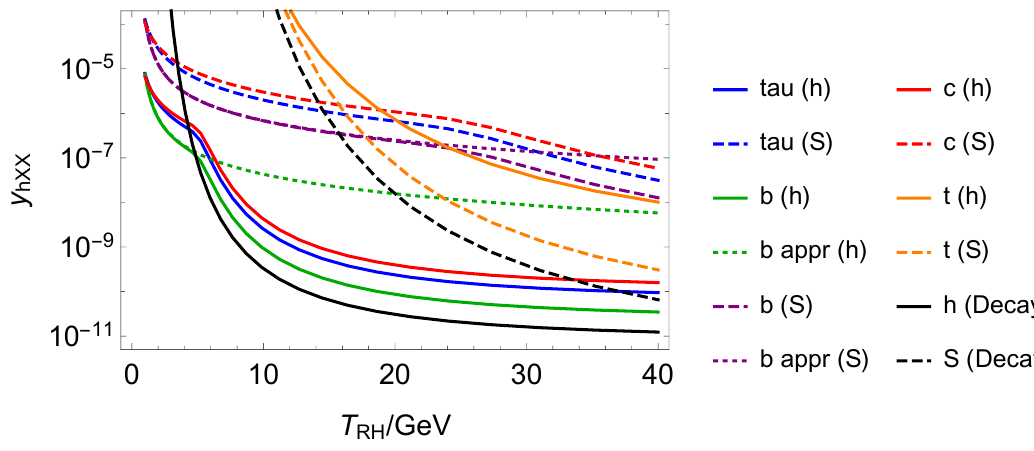
Figure 2 . Relative contributions of various annihilation channels, f ¯ f → X ¯ X , as a function of the reheat temperature for m X = 1 GeV, m S = 500 GeV, sin θ h = 0 . 1 . For each channel, we plot the effective Yukawa coupling, y hXX , needed to obtain the measured relic abundance. Lower curves correspond to the more dominant channels. The dotted curves are obtained using the approximate EFT formulae. For illustrative purposes, we also include the contributions from h and S decays (black solid and dashed curves,